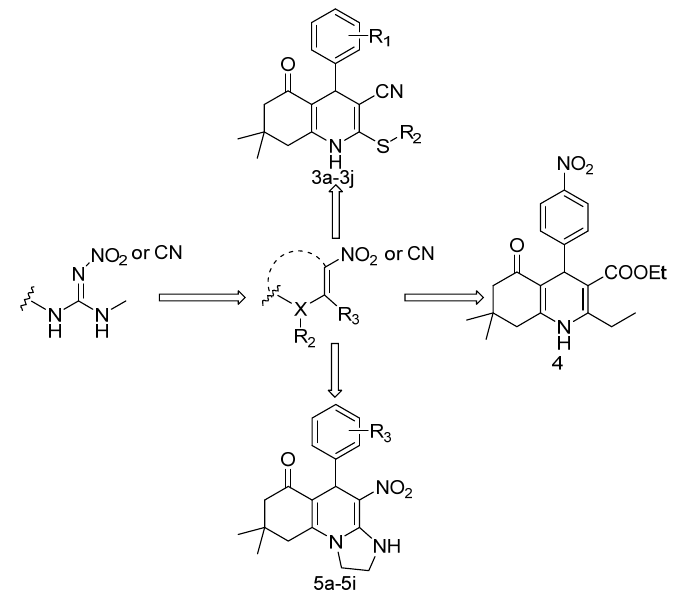
Figure 2. The molecular design of target compounds.